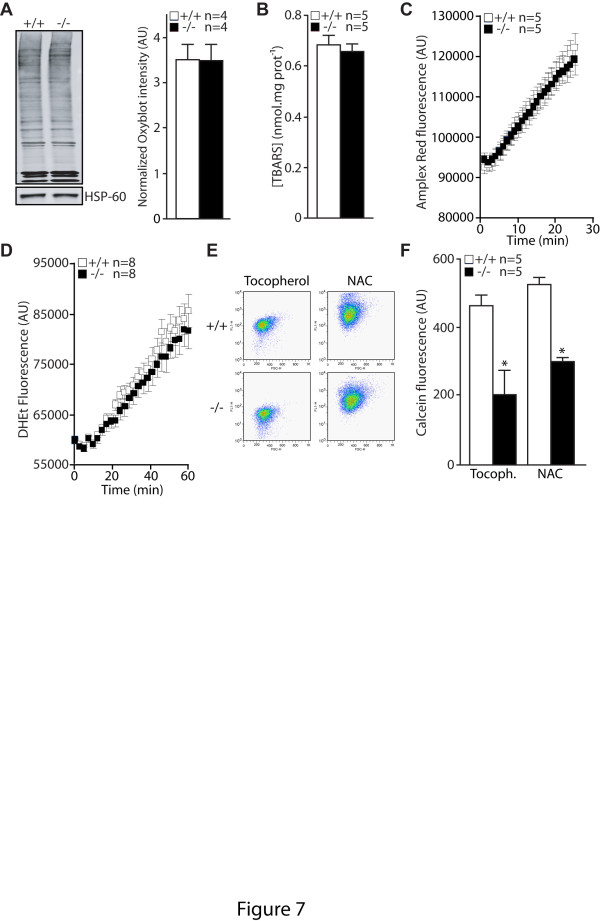
Normal levels of oxidative stress markers and normal production of reactive oxygen species inPINK1−/− MEFs. A. Left panel: OxyBlot analysis of mitochondrial fractions showing levels of protein carbonyls in both genotypes. Right panel: Quantification of levels of protein carbonyls in PINK1−/− and +/+ MEFs. B. Levels of lipid peroxidation measured by the TBARS assay in PINK1−/− and +/+ MEFs. C. Kinetics of H2O2 production in isolated mitochondria measured by following Amplex Red fluorescence over time. D. Kinetics of cytosolic superoxide anion O2- production measured in resuspended MEFs by following DHEt fluorescence over time. E. Representative flow cytometry dot plots showing calcein fluorescence in PINK1−/− and +/+ MEFs in the presence of Co2+ after antioxidant treatment with Tocopherol (50 μM, 4 hr) or NAC (1 mM, 2 hr). F. Quantification of calcein fluorescence in PINK1−/− and +/+ MEFs following treatment with Tocopherol (50 μM, 4 hr) or NAC (1 mM, 2 hr). All data are expressed as mean ± SEM. *p < 0.05.